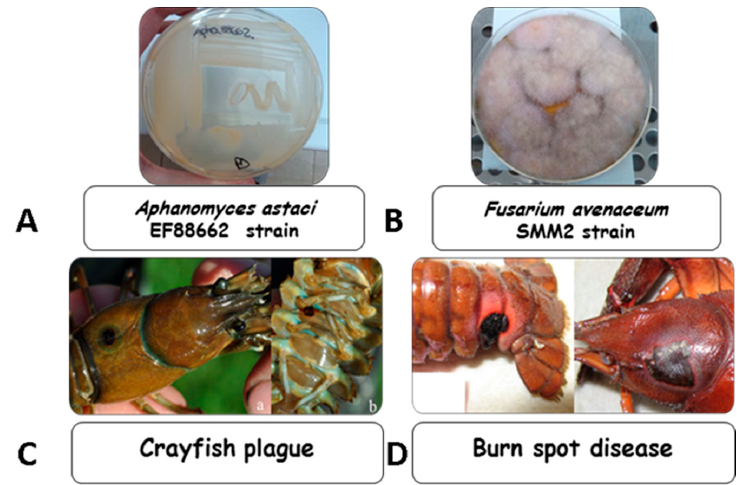
Figure 1. In the upper panel, Aphanomyces astaci strain 88662 ( A ) and Fusarium avenaceum strain SMM2 ( B ) grown on Potato-Dextrose (PD) agar (CONDA), a selective medium for the growth of yeasts and molds. In the lower panel, the injuries on the exoskeleton of a crayfish caused by Aphanomyces astaci , the etiological agent of “crayfish plague” ( C ) and Fusarium avenaceum , the etiological agent of the “burn spot disease” ( D